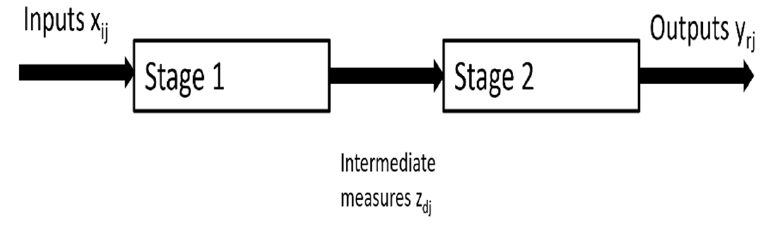
Figure 1. Typical structure of a two-stage DEA model.